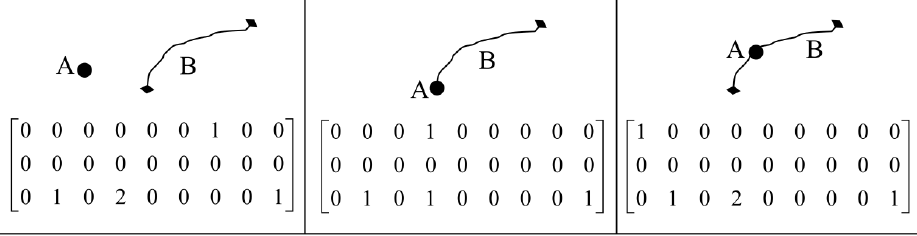
Figure 4. The formalism of the 27IM and the corresponding geometric interpretations between a point and a line.